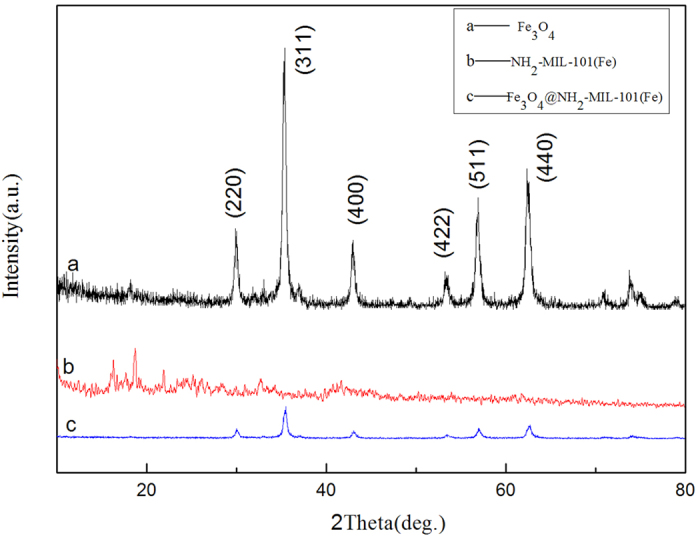
X-ay diffraction (XRD) patterns of (a) Fe3O4, (b) NH2-MIL-101(Fe) and (c) Fe3O4@NH2-MIL-101(Fe).